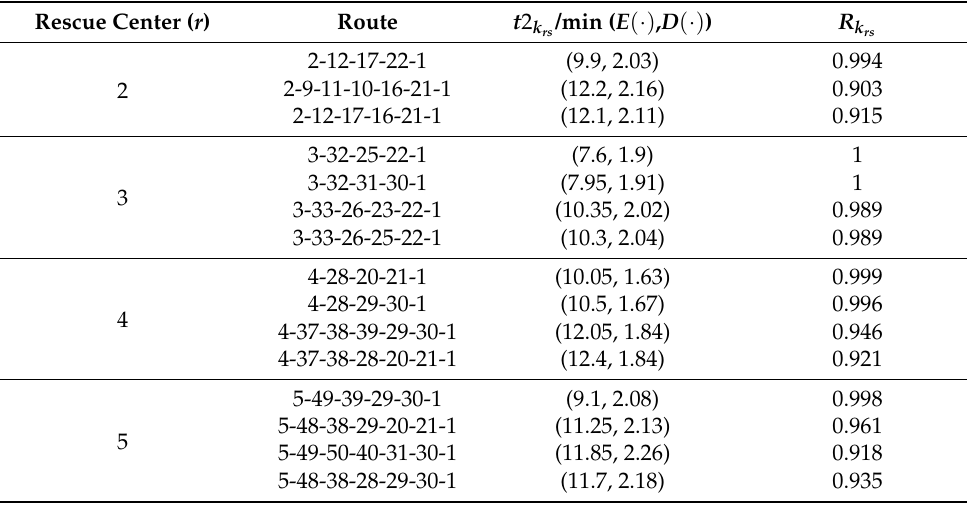
Table 9. Feasible routes and their reliability for rescue resource 2.